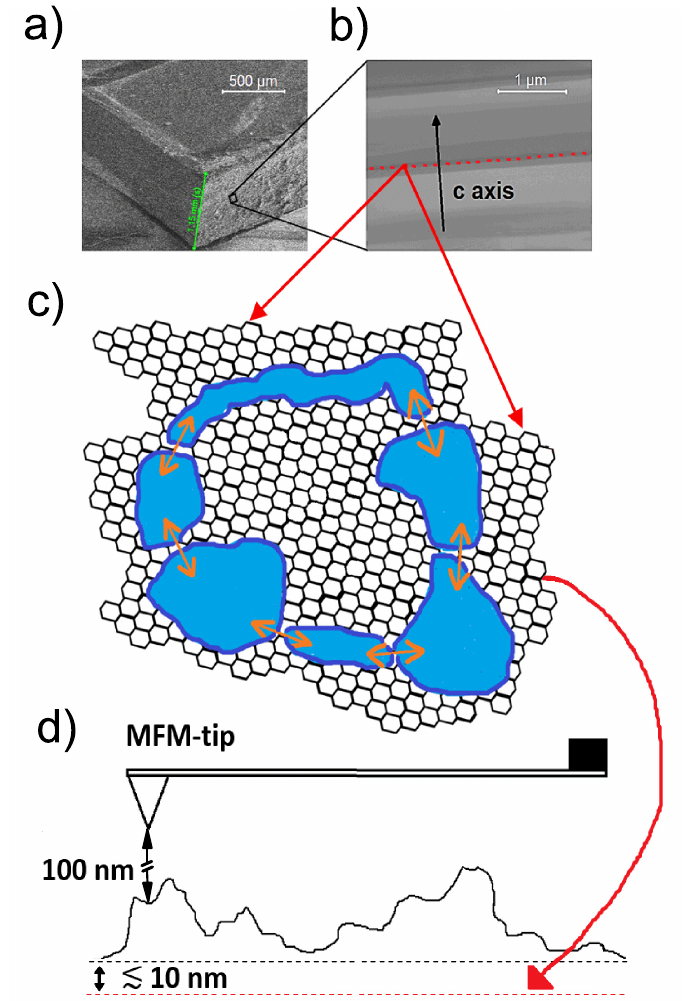
Figure 1. ( a ) Scanning electron microscope (SEM) of graphite bulk sample and ( b ) scanning transmis- sion electron microscope (STEM) scan of a lamella taken parallel to the graphene interfaces, where the c -axis is perpendicular to the crystalline planes. ( c ) Sketch of a 2D interface at an SF with embedded superconducting patches (blue regions) and Josephson current (orange arrows) circulating between them. ( d ) Sketch of the topography of a graphite sample with a superconducting SF (dashed red line) near the sample nominal main surface (dashed black line). The distance of the SF to the MFM tip depends on the position within the sample area, a fact that affects the absolute value of the measured phase change at the current path